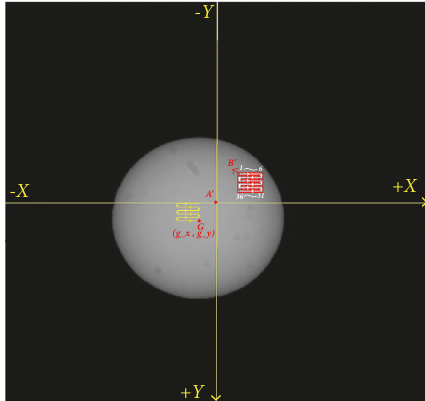
Figure 4: The principle of the proposed scanning method based on autoguiding